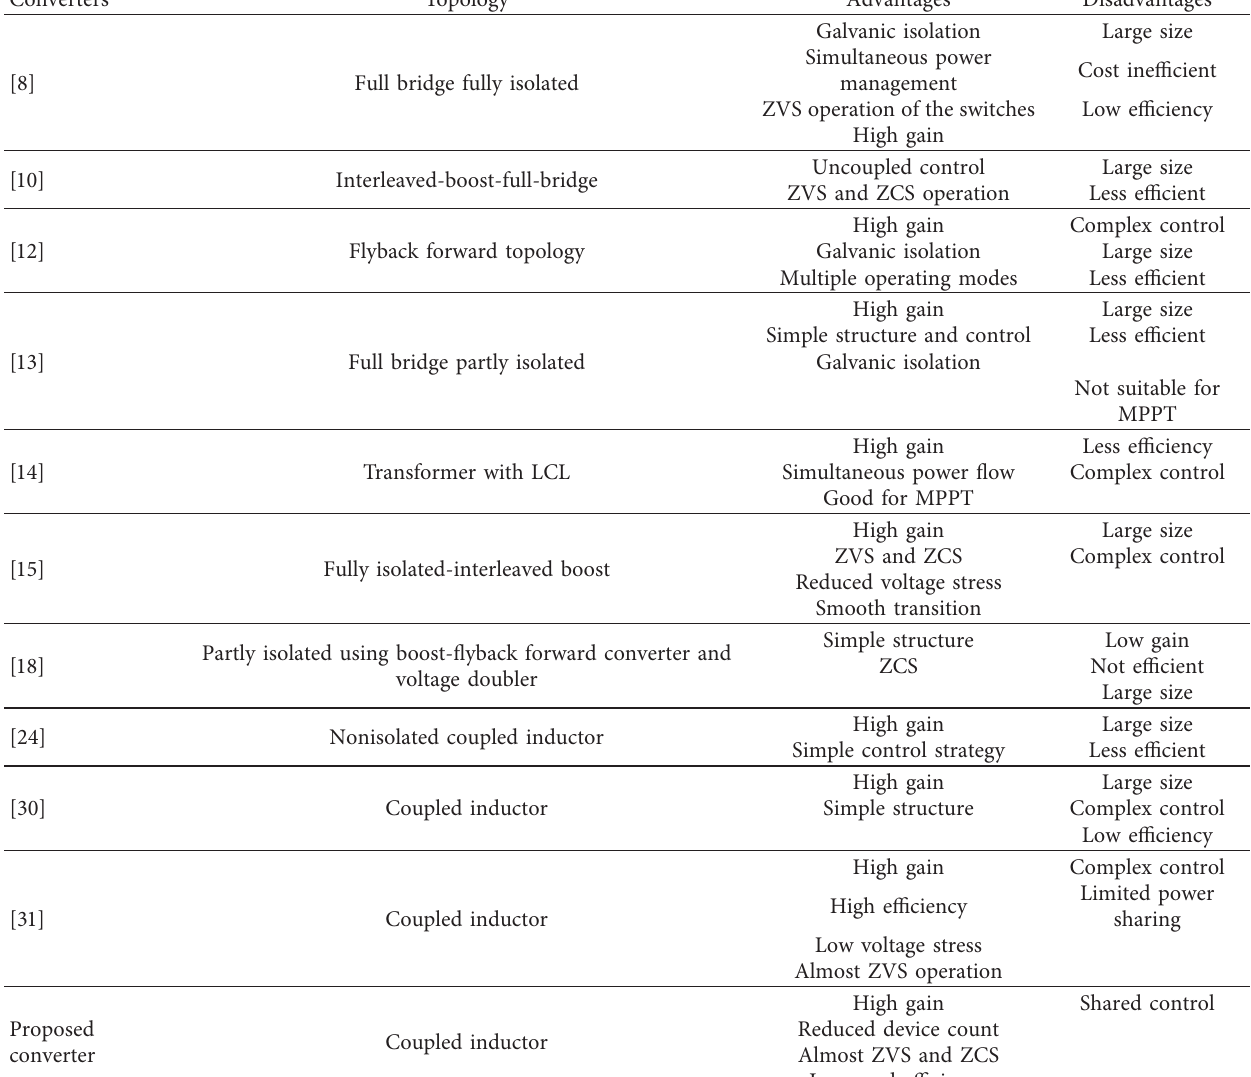
Table 6: Topological comparison of the proposed converter with other benchmarks: advantages, disadvantages, and applications.